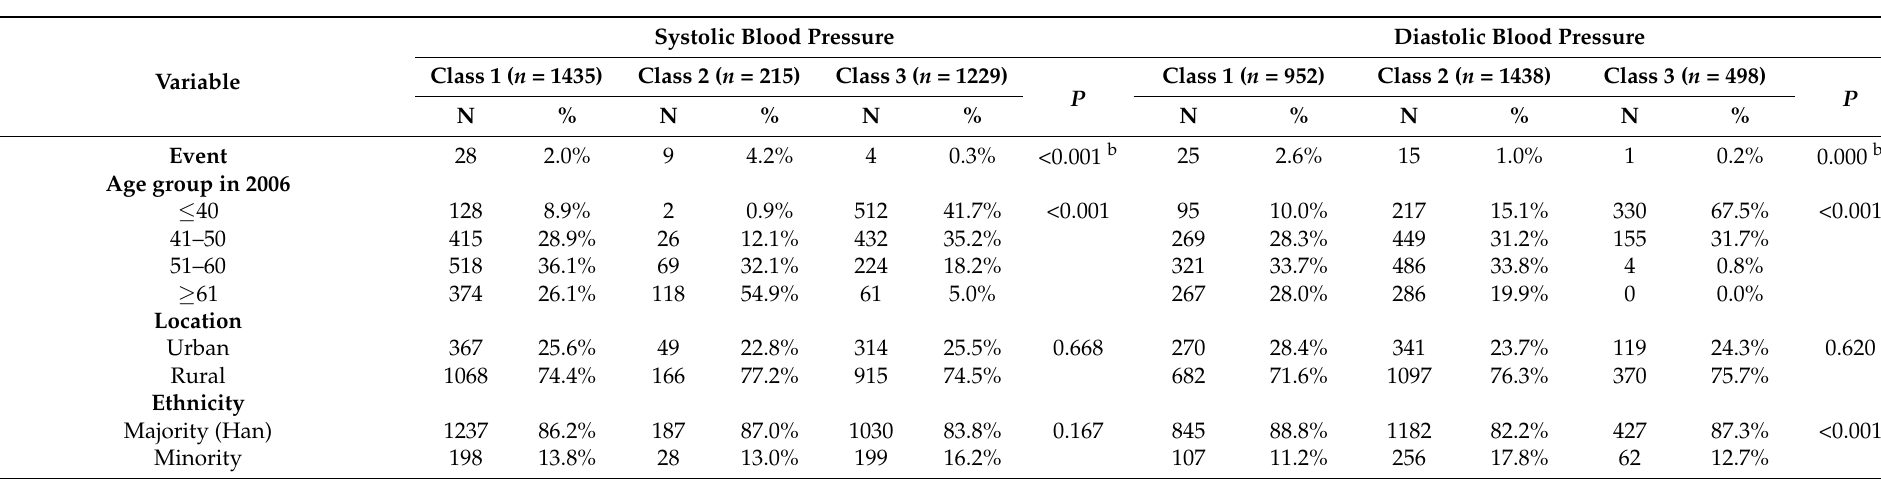
Table 3. The characteristics across blood pressure trajectory groups (systolic pressure and diastolic pressure, respectively) in the dataset of myocardial infarction ( N =